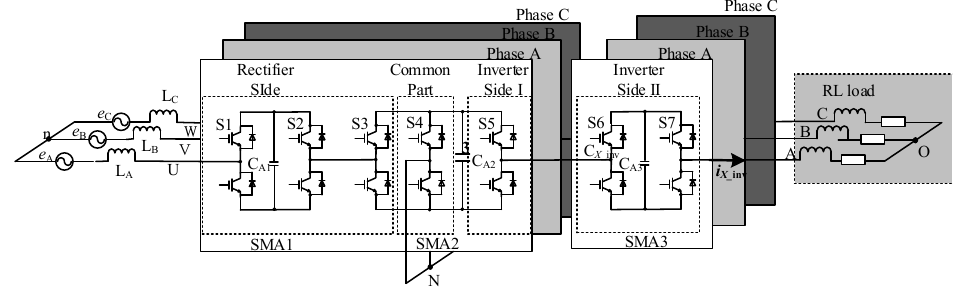
Figure 15. Circuit configuration of 5/3 level voltage source converter.